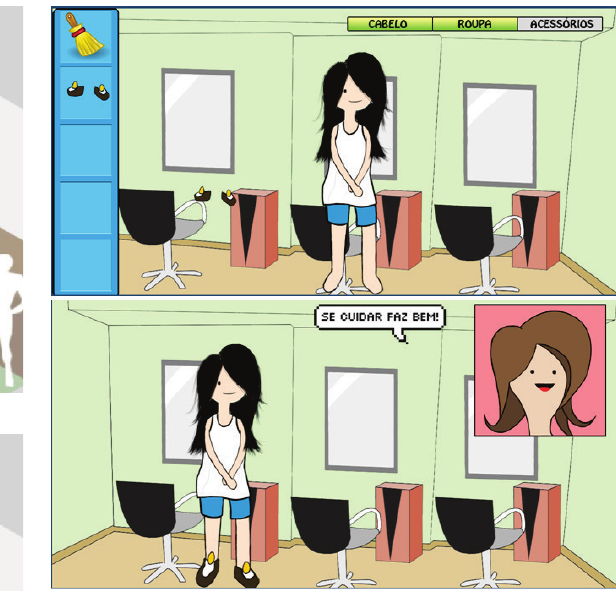
Fig. 13. Screenshot of the prototype of therapeutic game for